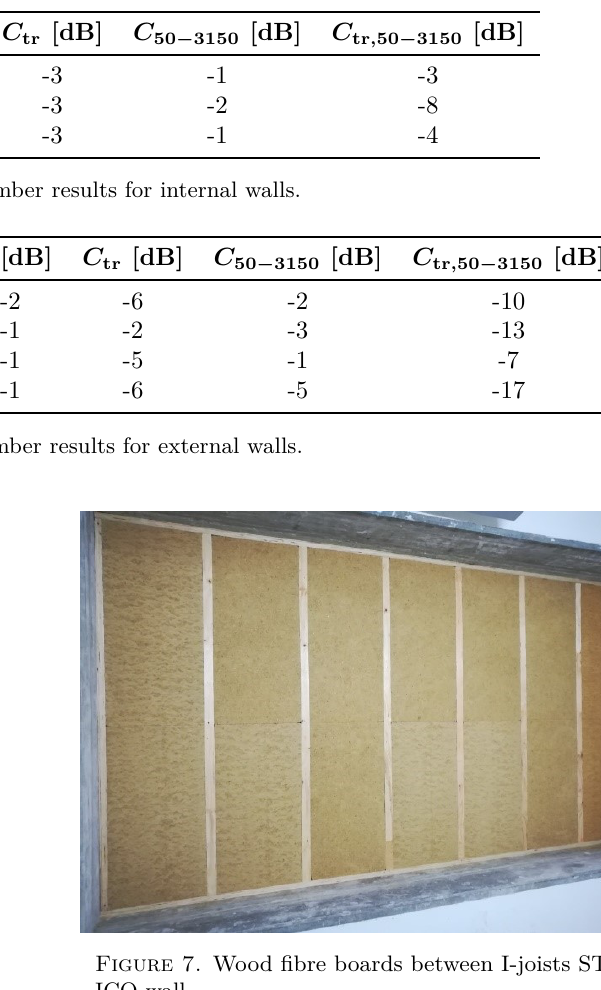
test elements are shown in Figures 7 and